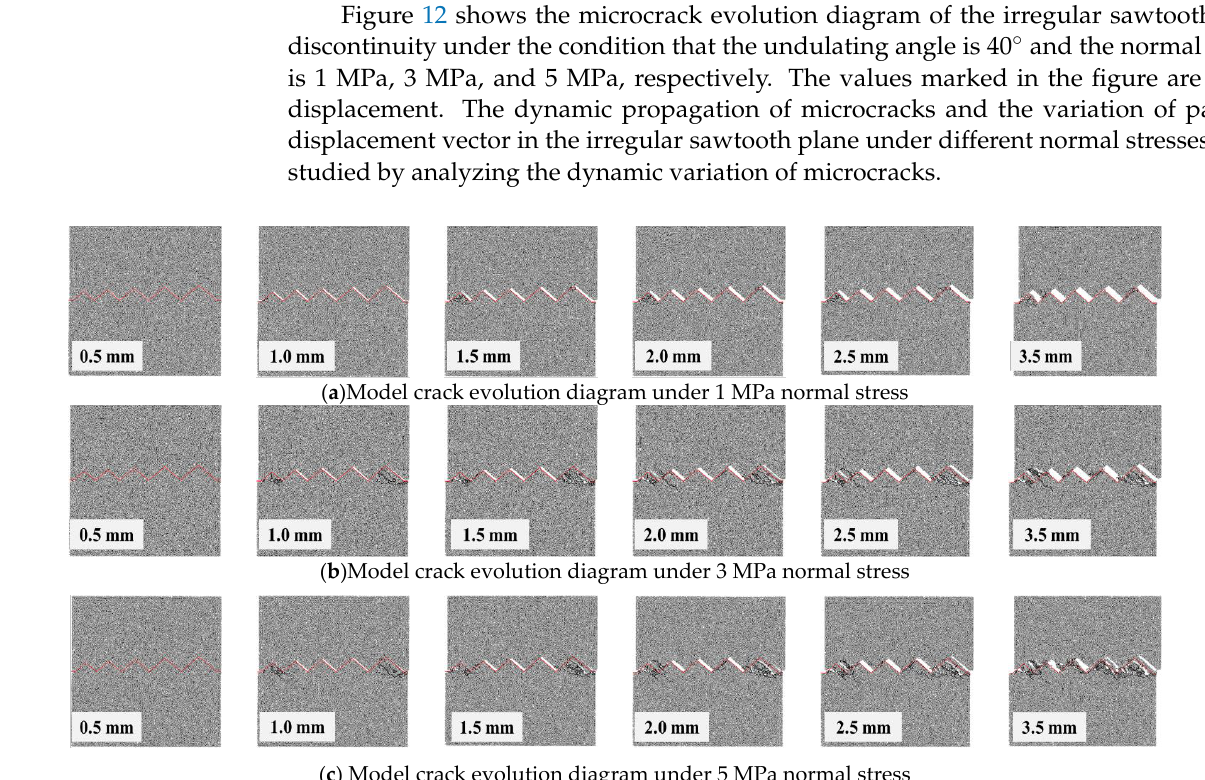
Figure 12. Model crack evolution under different normal stresses.